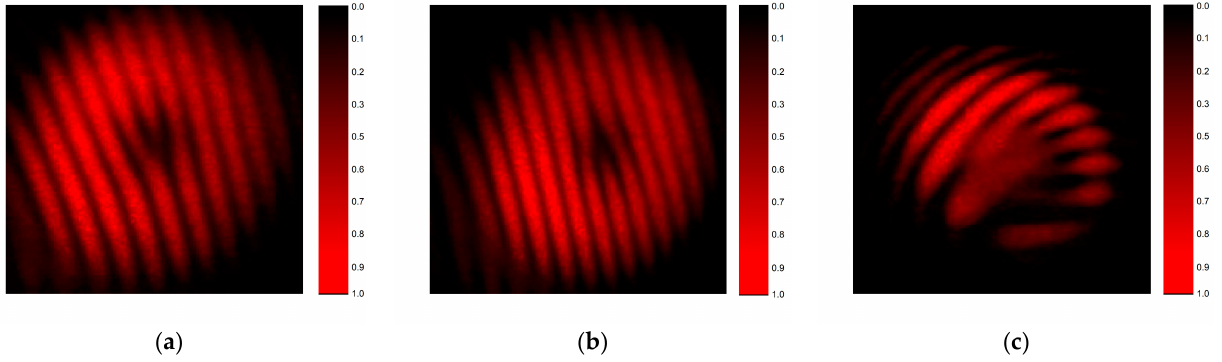
Figure 14. Fork interference patterns for beams generated by higher-order axicons with ( a ) m = 1, ( b ) m = − 1, ( c ) m = − 4. ( b ) m = − 1, ( c ) m = −